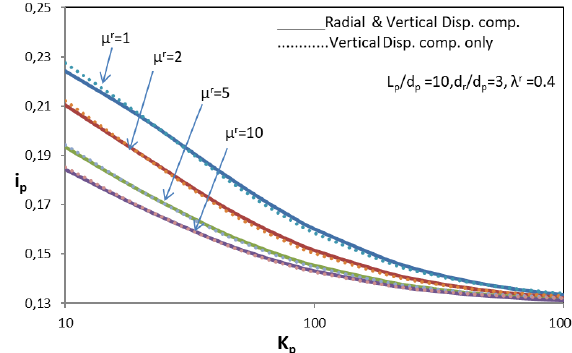
, with comparative strengthening, K Figure 3: Variation of SIF, i p of GP– effect of strengthening factor, μ r , and radial and vertical settlement compatibility on partially strengthened GP–raft